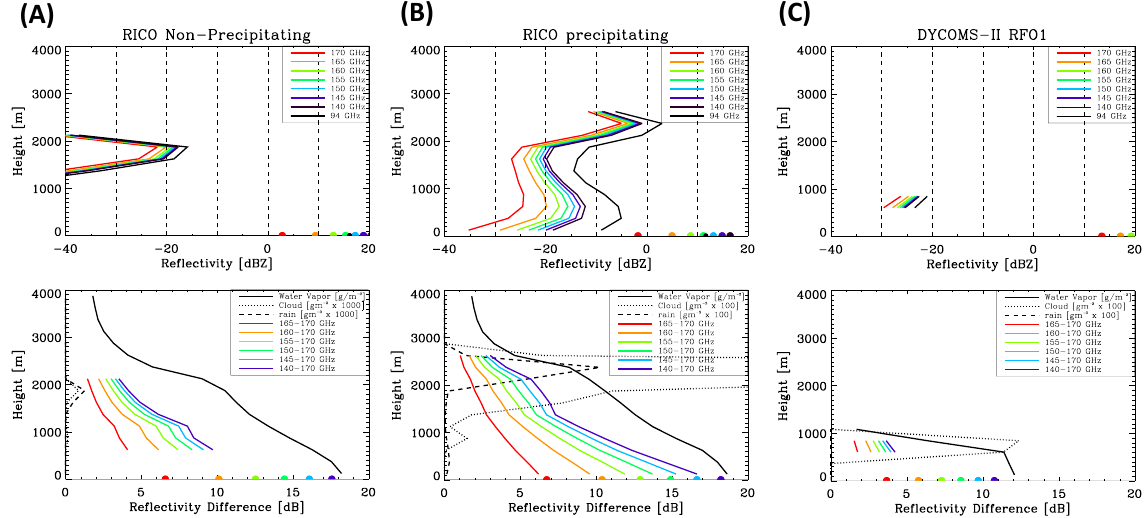
Figure 6. Reflectivity profiles (top) and reflectivity difference (bottom) for a non-precipitating RICO pixel (a) , a precipitating RICO pixel (b) , and a DYCOMS pixel (c) . These examples have been averaged to the antenna gain function and range resolution. The dots at the height = 0 level show the surface reflectivity. In the bottom panels the water vapor profile and cloud and precipitation profiles are also